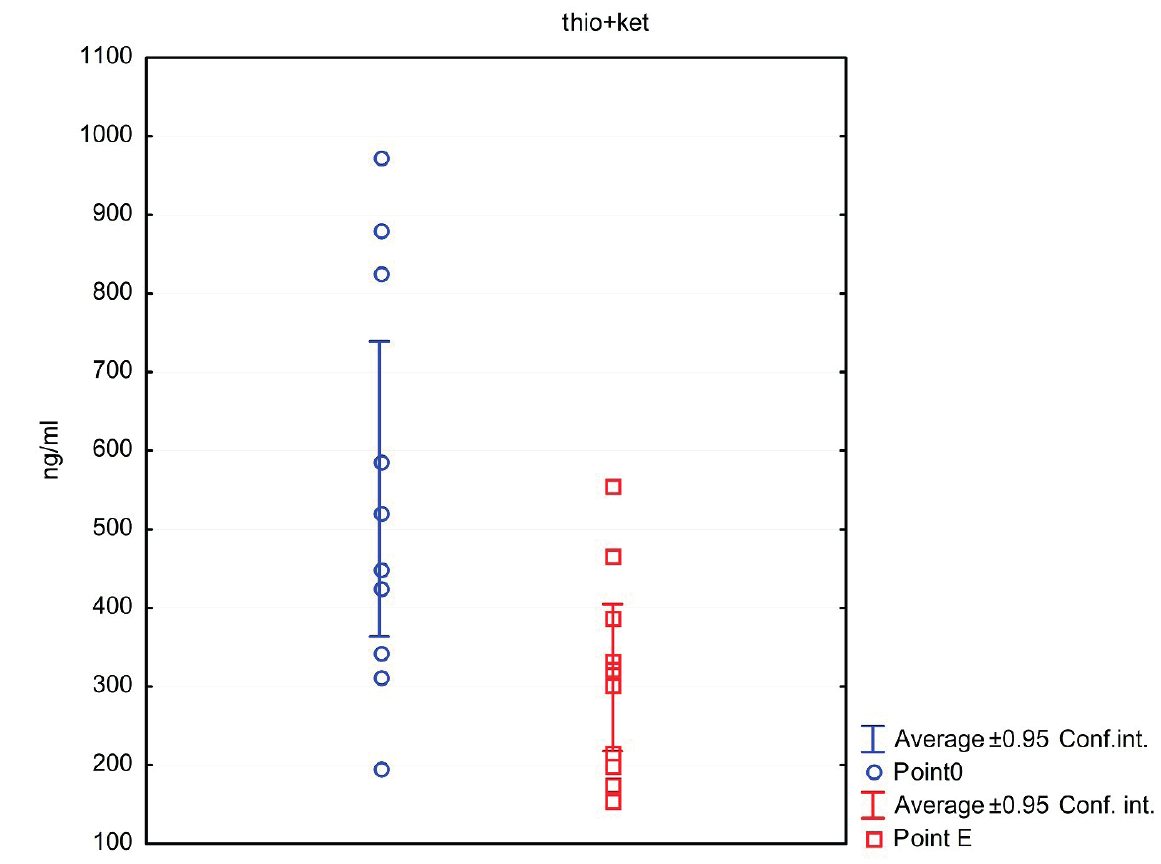
Fig. 3 Scatter plot with 95% confidence interval showing average concentrations of MMP-9 in patients where thiopental and ketamine were used as an anaesthetic at two points in